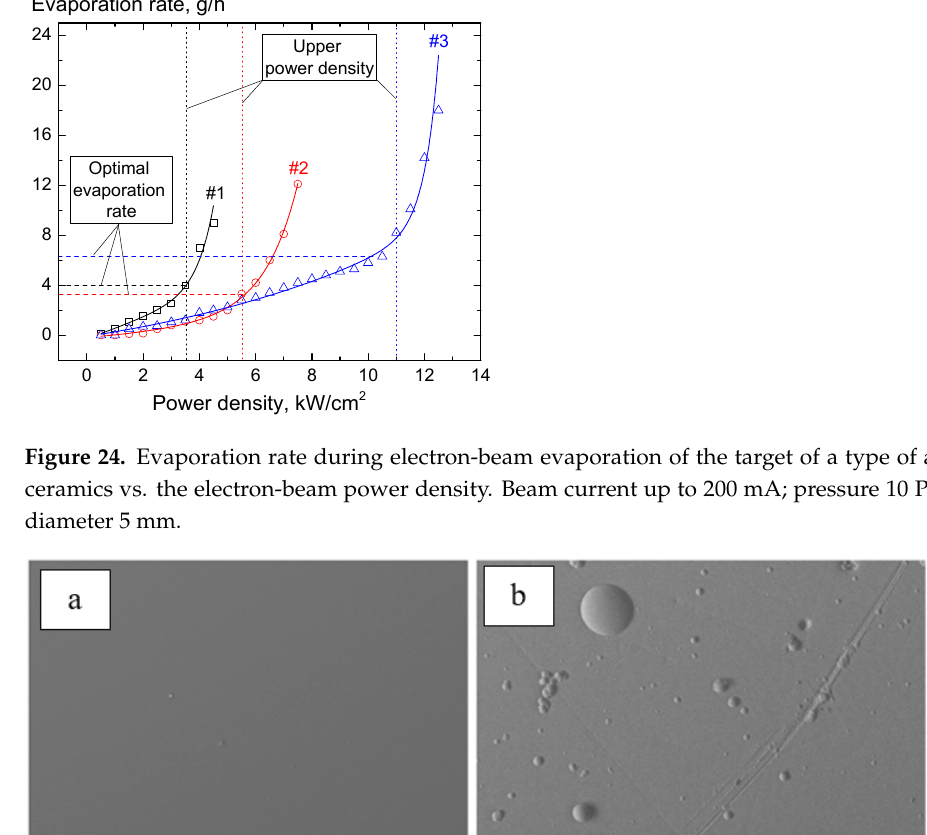
Figure 23. Elemental composition and micrographs of the coating deposited on a titanium substrate [134].